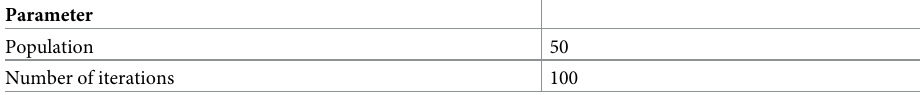
Table 3. Parameter settings of all metaheuristic algorithms for optimizing RVFL.